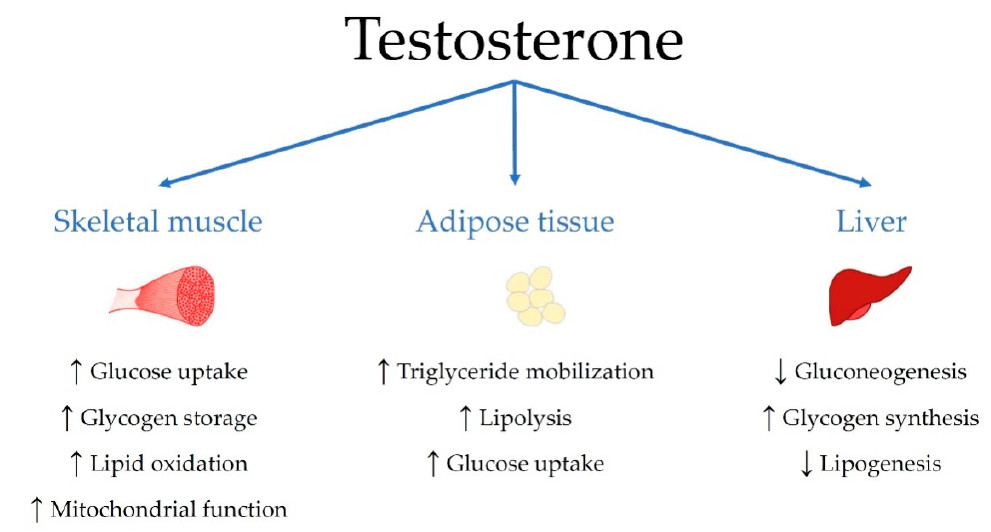
Figure 1. Potential actions of testosterone treatment on insulin ‐ sensitive tissues.